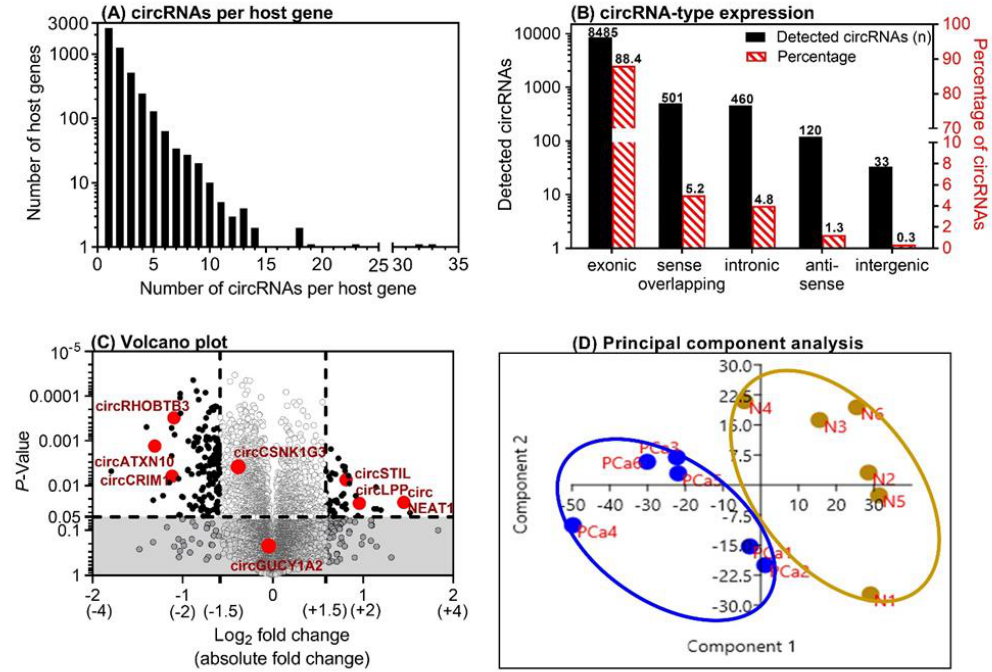
Figure 2. Microarray analysis results of six matched prostate cancer (PCa) tissue samples. ( A ) The number of circular RNAs (circRNAs) expressed per host gene in the malignant tissue samples and their matched adjacent normal tissue samples from PCa specimens after prostatectomy. ( B ) Genomic origin of the detected circRNAs on the microarray. ( C ) Volcano plot with the up- and downregulated circRNAs in malignant vs. adjacent normal tissue samples. The dashed lines indicate the thresholds: absolute 1.5-fold changes and p -values of 0.05 in the t -test. The eight circRNAs that were selected for further evaluation in this study are marked. ( D ) Results of the principal component analysis with the left cluster of tumor samples (PCa1–PCa6, marked in blue) and the right cluster with the paired adjacent normal tissue samples (N1–N6, marked in